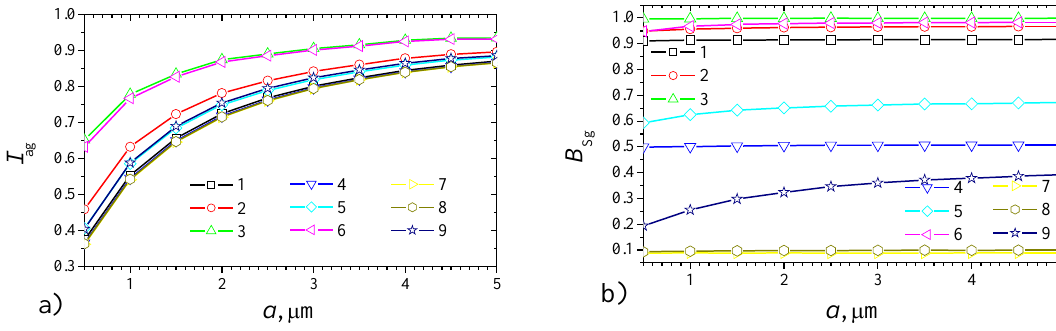
Figure 10 . The normalized steady state current (a) and the biosensor sensitivity (b) vs. the gap width a of the plate − gap biosensor, δ = 2 µ m, b = a +2 µ m. Other parameters and the notations are the same